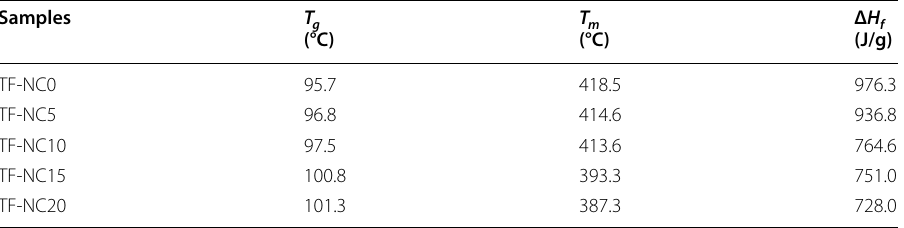
), melting temperature ( T g